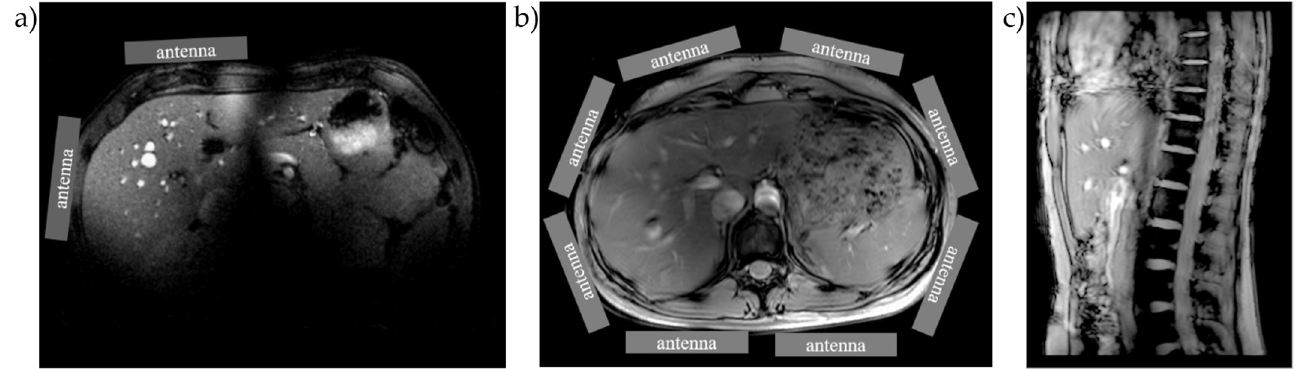
Figure 3. The capabilities of multiple antenna elements deployed for signal excitation and collection for proton imaging. ( a ) Two antennas (in quadrature) are sufficient for localizing the liver for phos- phorus spectroscopic imaging; ( b , c ) clinical-grade proton imaging can be achieved with 8 antennas with parallel transmit and B1 shimming. In ( b ) the full extent of the liver is visualized in an axial slice (as well as white and grey matter in the spinal cord). In ( c ) a sagittal slice shows the longitudinal coverage provided by antennas, which will be useful for identifying metastases in the peritoneum. Images adapted from Rivera et al. [24].